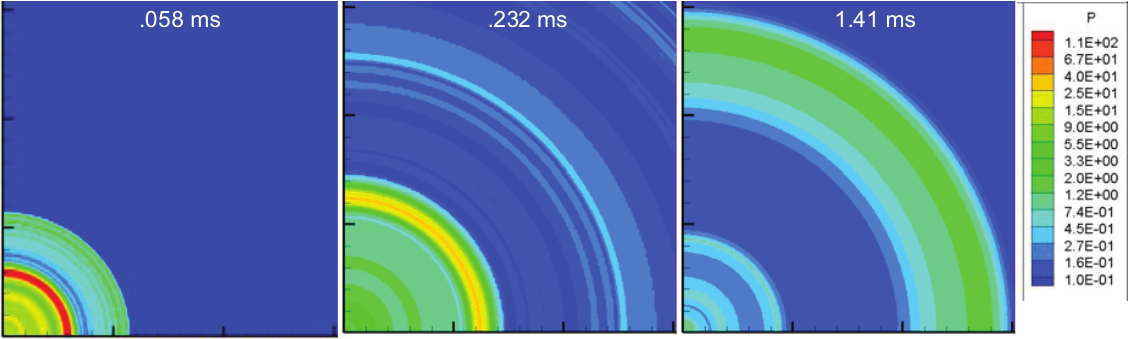
Fig. 12. Plate surface pressure distribution (MPa).